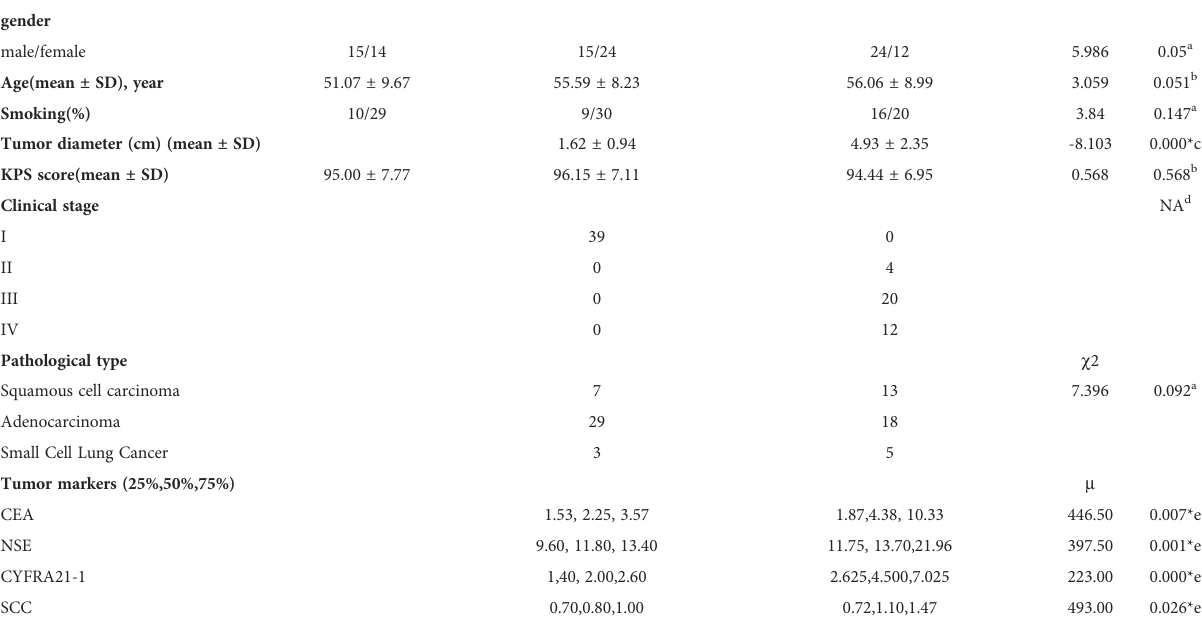
TABLE 1 Demographic and clinical features of patients with lung